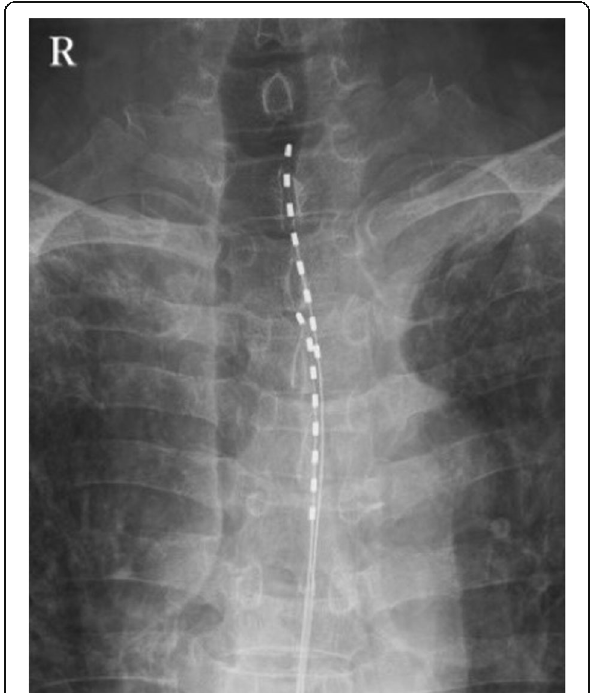
Fig. 1 Fluoroscopy image of the spinal cord stimulator. Two electrodes were introduced into the epidural space from the T12/L1 intervertebral space. The tip of the first electrode was positioned slightly to the left of the midline at the level of T1. The second electrode was on the caudal side of the first